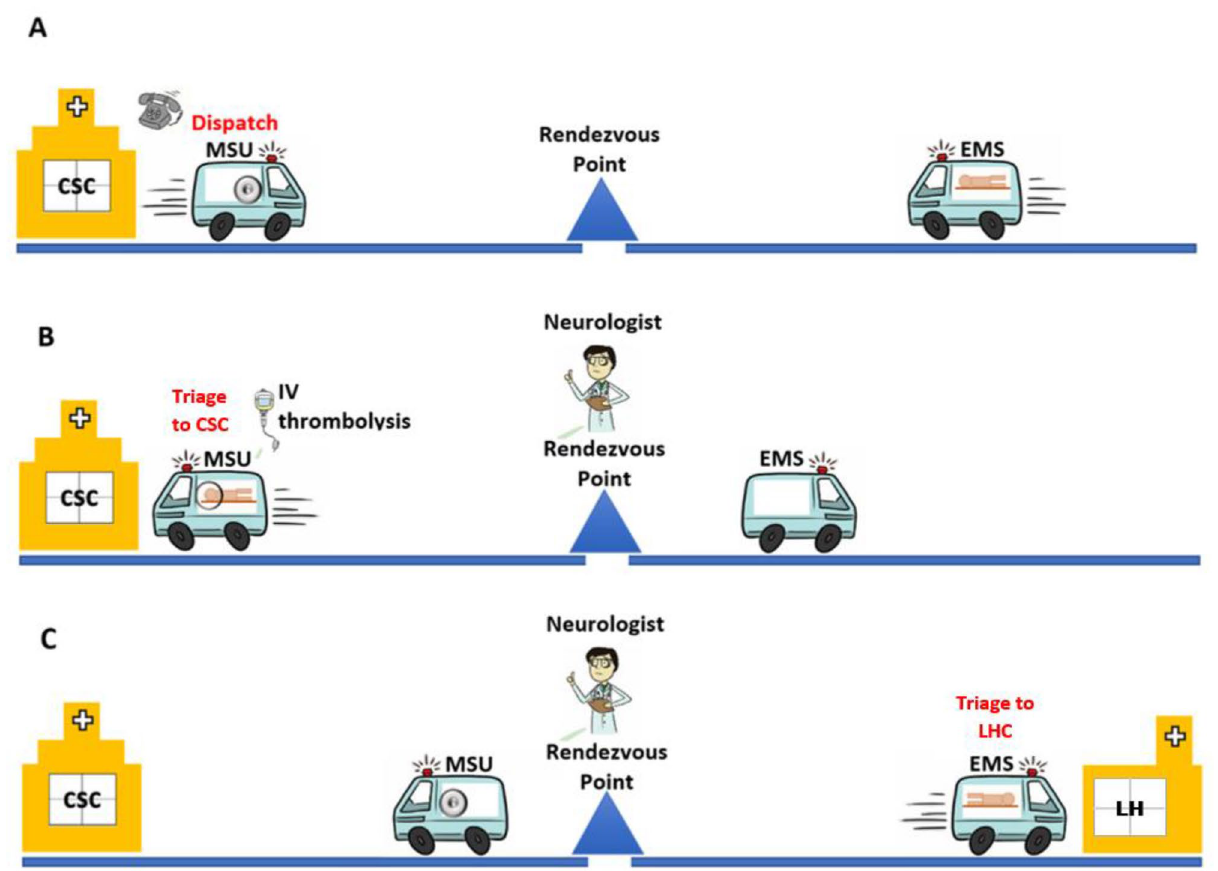
Figure 2. Dispatch of Mobile Stroke Unit and Transportation of Patients. (A) Mobile Stroke Unit (MSU) was dispatched from comprehensive stroke center (CSC) to meet Emergency Medical services (EMS) ambulance at a Rendezvous point in the field usually midway between travel. (B) If the clinical assessment by Stroke Fellow and imaging suggests acute stroke requiring thrombolysis or need of advanced care, the patient was transported to CSC with possible en-route IV thrombolysis. (C) If the clinical assessment by Fellow and imaging was suggestive of minor stroke or a stroke mimic not requiring advanced care, the patient was transported to the nearest home hospital (HH) or local hospital